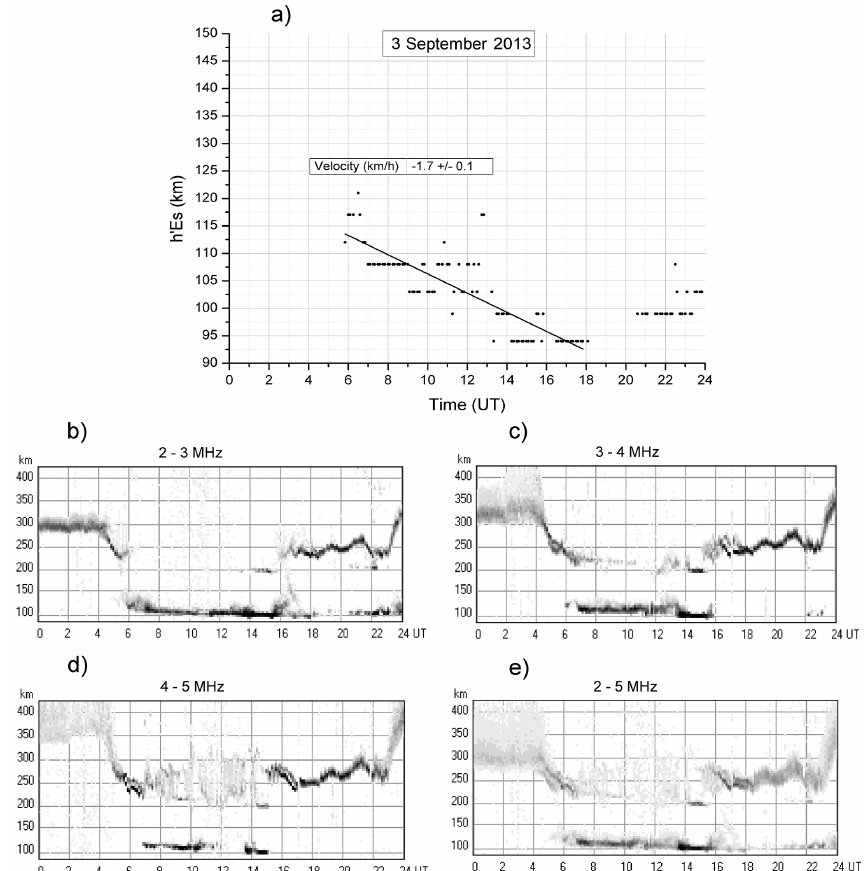
Figure 9. (a) h’Es values manually validated for the 3 September 2013, with the corresponding linear fits, and the HTI plots generated for the same day for different frequency ranges: (b) 2–3MHz, (c) 3–4MHz, (d) 4–5MHz, and (e)